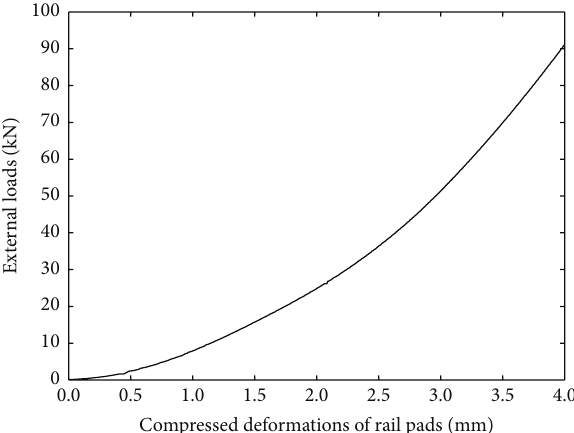
Figure 2: The average load-deformation curve of three TPE rail